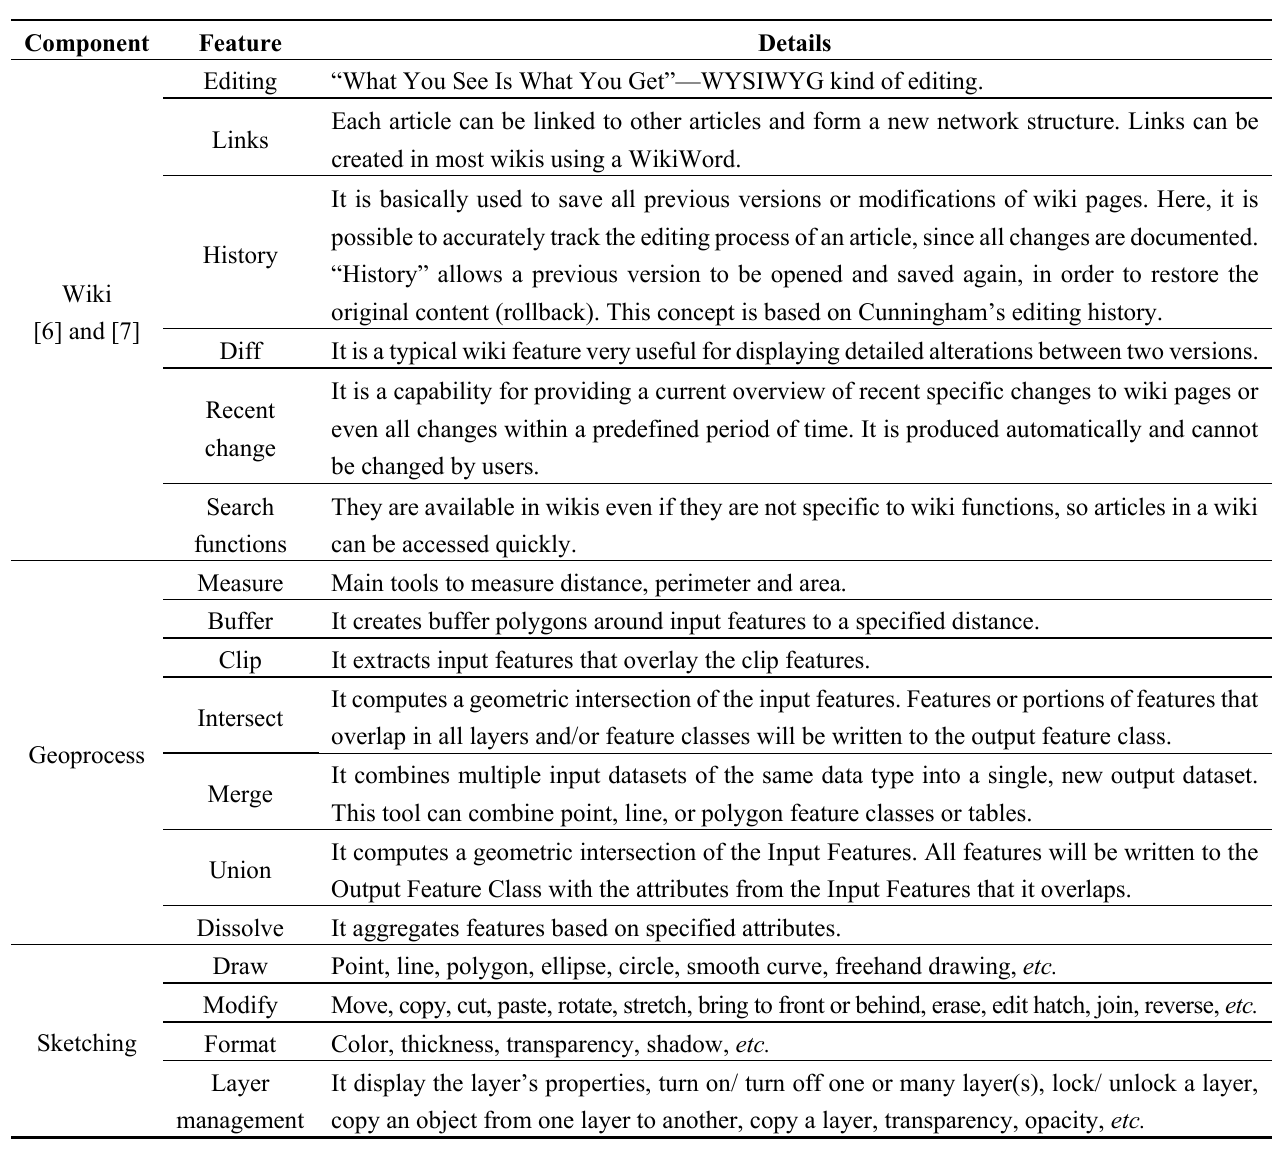
Table 1. Main features of WikiGIS.